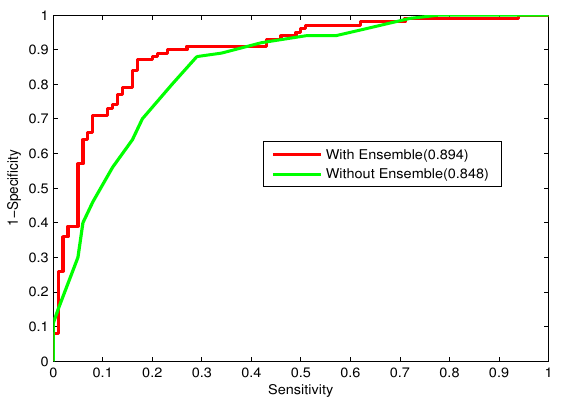
Figure 6. ROC curves with and without the stacking-based ensemble learning method.